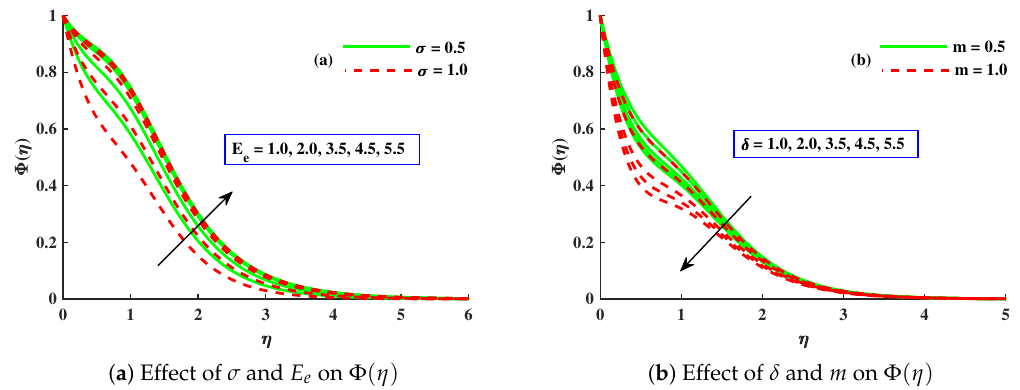
Figure 9. Curves of Φ ( η ) with σ , E e δ , and m .